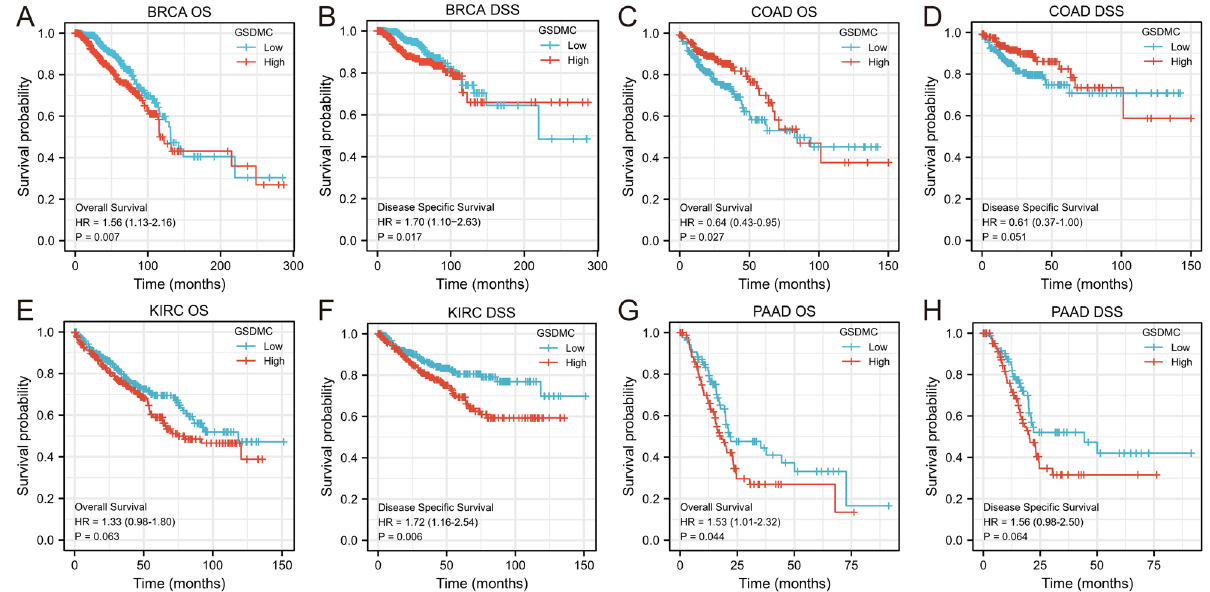
Figure 4. Prognostic analysis of GSDMC mRNA expression levels in different tumor types in the TCGA database ( A–H ). * P < 0.05, ** P < 0.01, *** P < 0.001. OS overall survival, DSS disease-specific